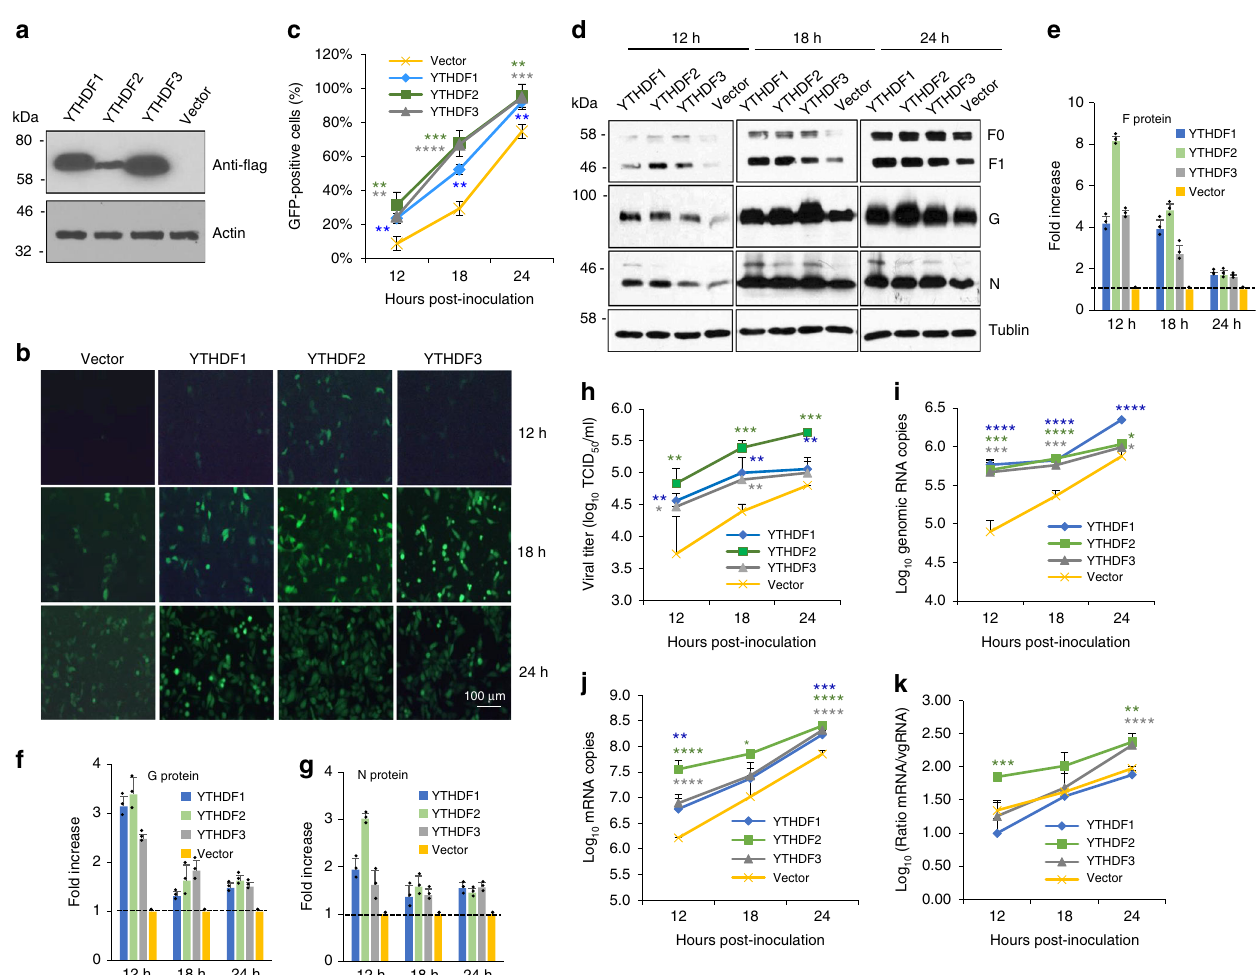
Fig. 2 YTHDF1, 2, 3 (reader) proteins promote RSV replication, gene expression, and progeny virus production. a Detection of YTHDF1, 2, 3 in HeLa cells stably overexpressing YTHDF1-3. Western blot con fi rmed the overexpression of YTHDF1-3 proteins in HeLa cells using anti-Flag antibody. b YTHDF1, 2, 3 enhance GFP expression in rgRSV-infected cells. HeLa cells stably overexpressing these YTHDF proteins were infected with rgRSV at an MOI of 0.1, and GFP expression was monitored at the indicated times by fl uorescence microscopy. Micrographs with ×10 magni fi cation (scale bar of 100 μ m) are shown. c YTHDF1, 2, 3 increase the number of GFP-positive cells quanti fi ed by fl ow cytometry. The P value (Student ’ s t -test) for YTHDF1 at 12, 18, and 24 h is ** P = 0.00297, ** P = 0.00145, and ** P = 0.00202, respectively; for YTHDF2 at 12, 18, and 24 h is ** P = 0.00318, *** P = 0.000892, and ** P = 0.00312, respectively; for YTHDF3 at 12, 18, and 24 h is ** P = 0.00119, **** P = 5.19 × 10 − 5 , and *** P = 0.000647, respectively. d YTHDF1, 2, 3 enhance RSV protein expression. Total cell extracts were harvested from rgRSV-infected HeLa cells at the indicated times and subjected to western blot using antibody against RSV N, F, or G protein. Western blots shown are the representatives of three independent experiments. RSV F (F0 + F1) ( e ), G ( f ), and N ( g ) proteins were quanti fi ed by Image J Software. Data are expressed as mean of three independent experiments ± standard deviation. h YTHDF1, 2, 3 increase RSV progeny virus production. The release of infectious RSV particles was monitored by a single-step growth curve. Virus titer was measured by TCID 50 . The P value